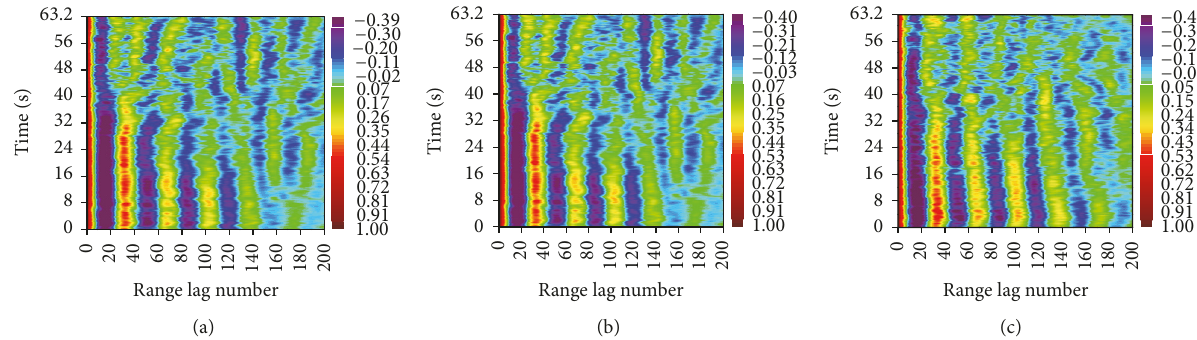
Figure 14: The spatial correlations of the texture for DS2: (a) Sum channel. (b) Elevation difference channel. (c) Azimuth difference